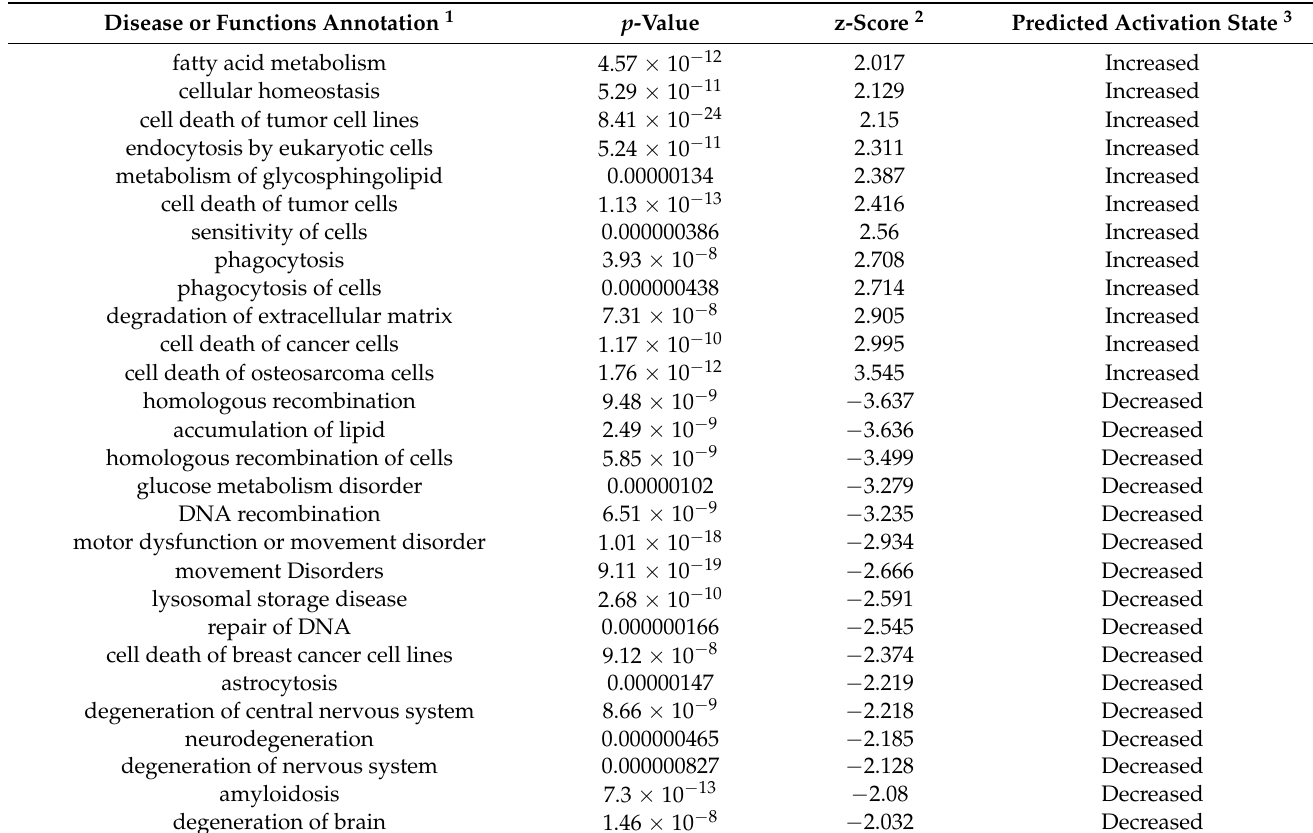
Table 6. Selected disease or functions that are predicted to be increased or decreased on the basis of differential proteins in HF-MSS, based on Ingenuity Pathway